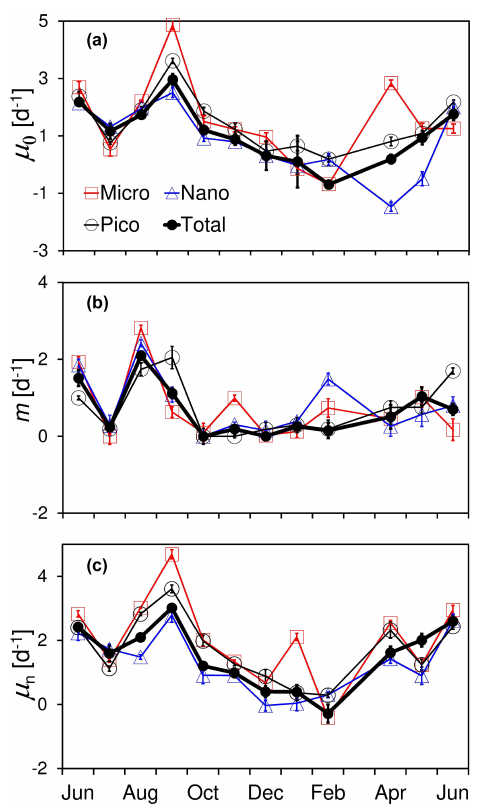
Figure 5. Temporal variations in (a) natural phytoplankton growth rate ( µ 0 ), (b) microzooplankton grazing rate ( m ), and (c) nutrient- enriched phytoplankton growth rate ( µ n ), as well as their size- fractionated components for micro-, nano-, and pico-cells at the Wanshan station from June 2018 to June 2019. Error bars are stan- dard errors from dilution